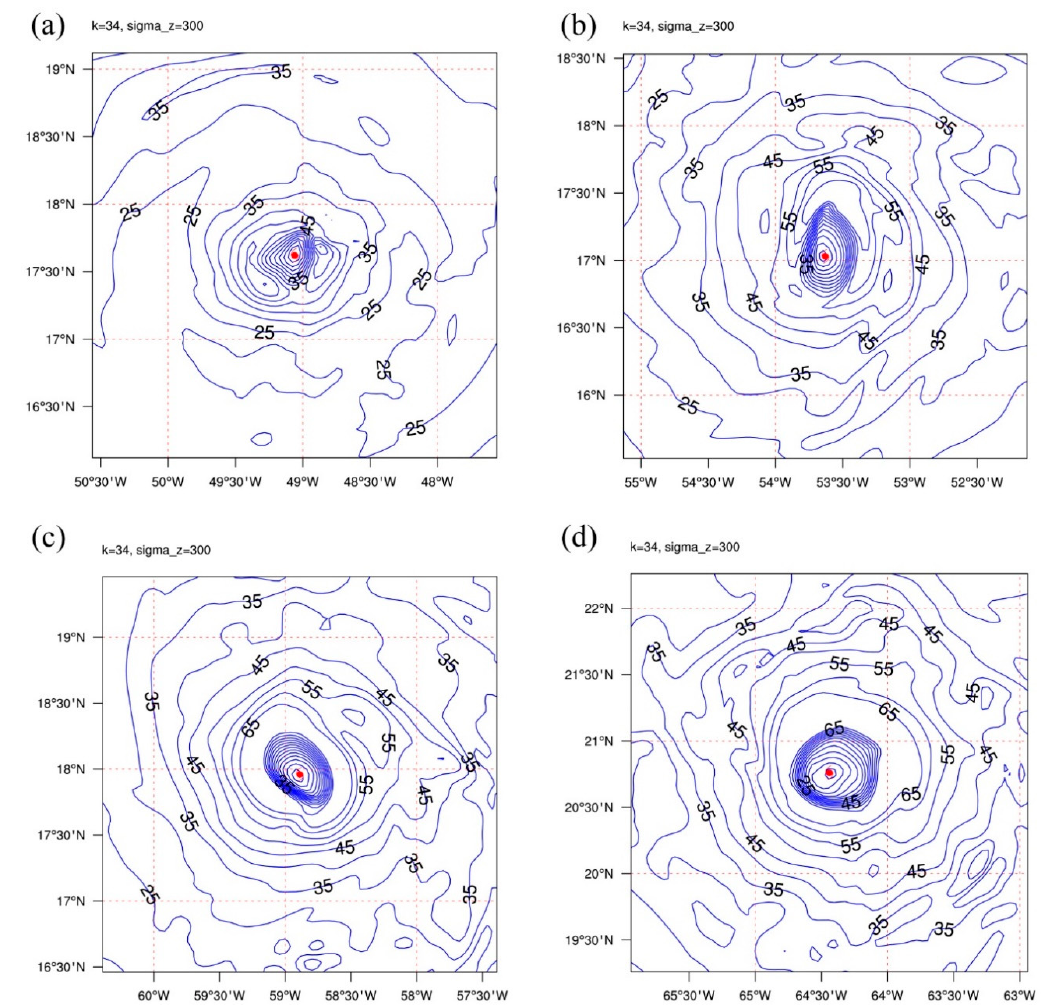
Figure 14. ( a ) Warm-start initial conditions (tau = 0 h) at 1800 UTC 3 September from the 15 min AMV FCDI analysis, and then COAMPS-TC forecasts at ( b ) tau + 24 h, ( c ) tau + 48 h, and ( d ) tau + 72 h for z = 300 m wind isotachs at 5 m s − 1 intervals from 5 to 65 m s − 1